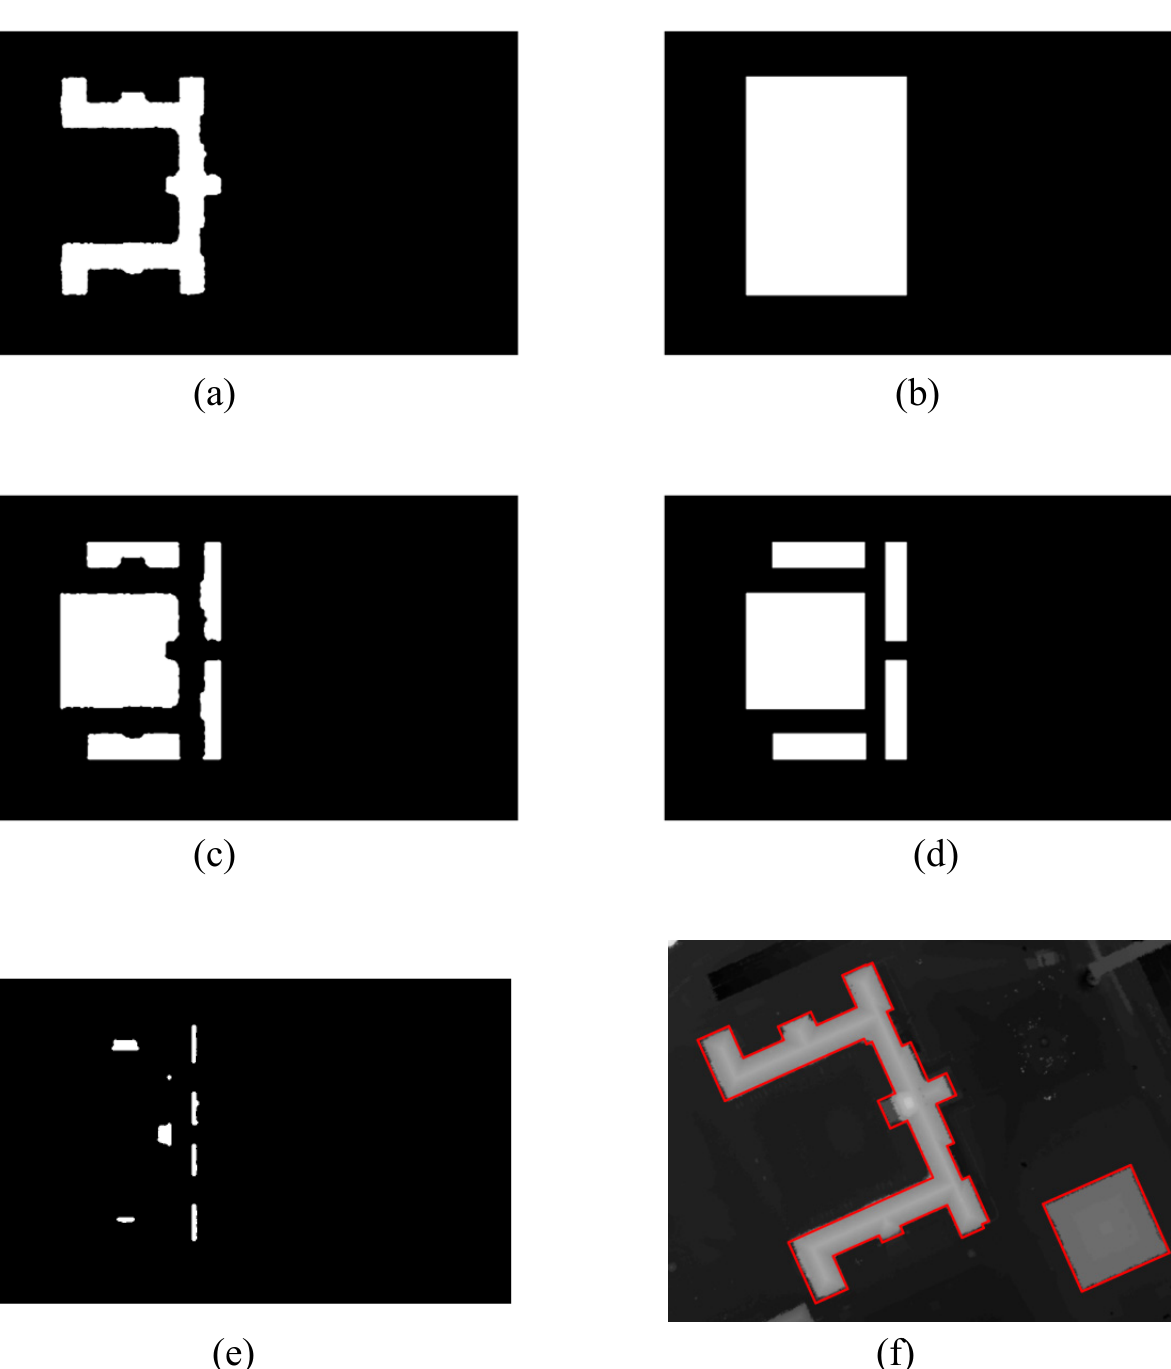
Figure 10. MBR-based polygon approximation. ( a ) Rotated building; ( b ) MBR image; ( c ) Rotated region–MBR region; ( d ) MBR on small regions; ( e ) New regions produced by subtraction of (c,d); ( f ) Superimposed final rectilinear polygons (red) on